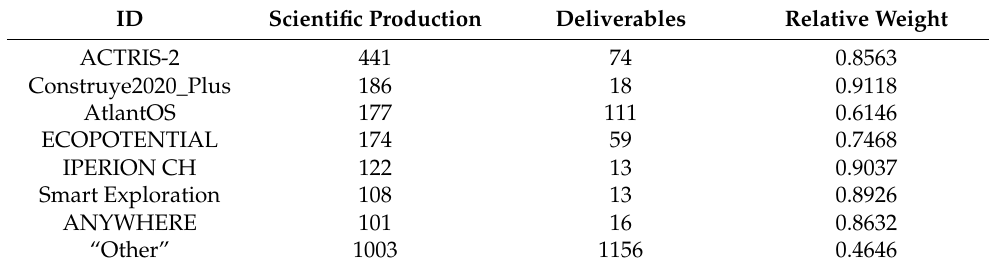
Table 1. Project outcomes.